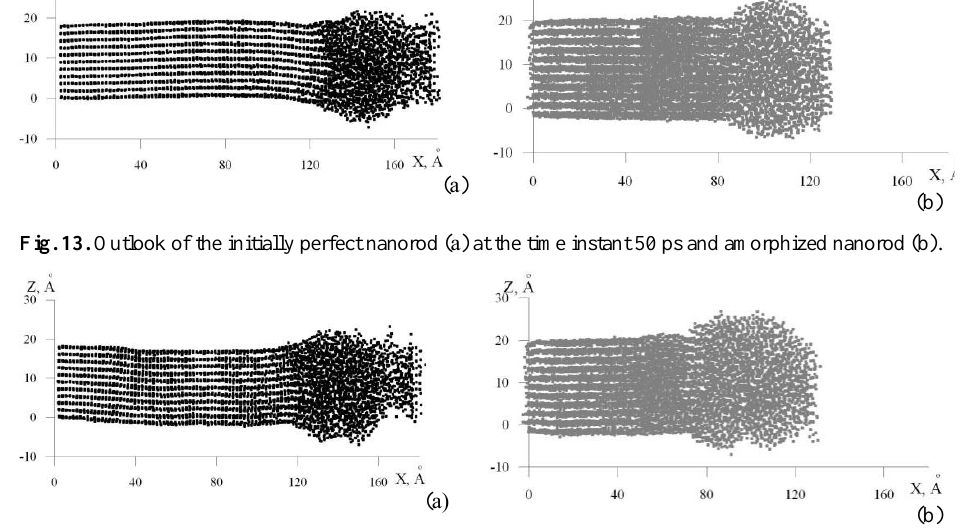
Fig. 14. Outlook of the initially perfect nanorod (а) at the time instant 70 ps and amorphized nanorod